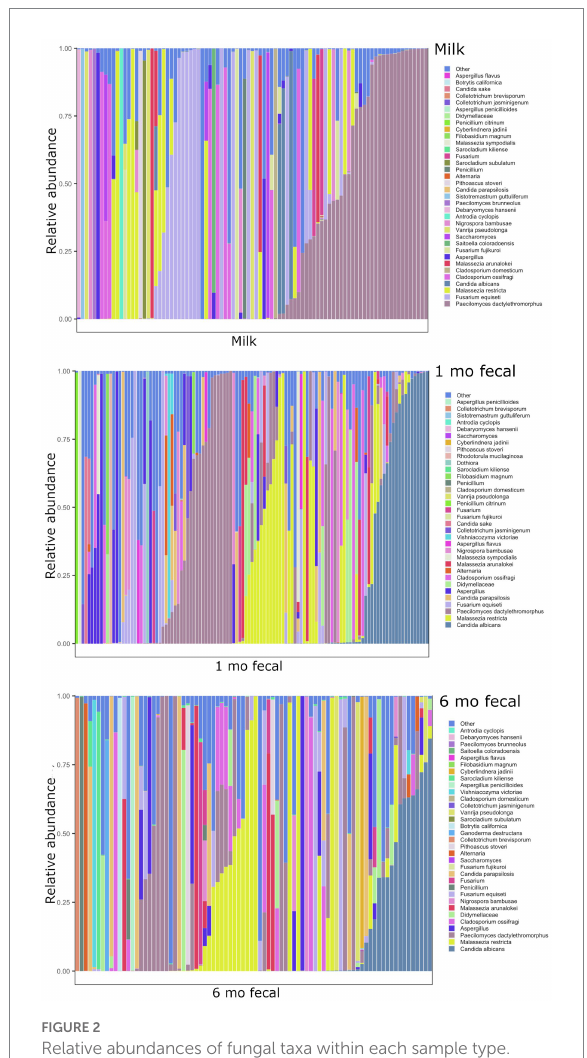
FIGURE 2 Relative abundances of fungal taxa within each sample type. Each bar represents an individual sample, and samples are ordered by subject. “Other” represents taxa whose relative abundance is minimal as compared to the taxa included on the plot. Samples: n = 91 for breastmilk, 115 for 1-month feces, and 84 for 6-month